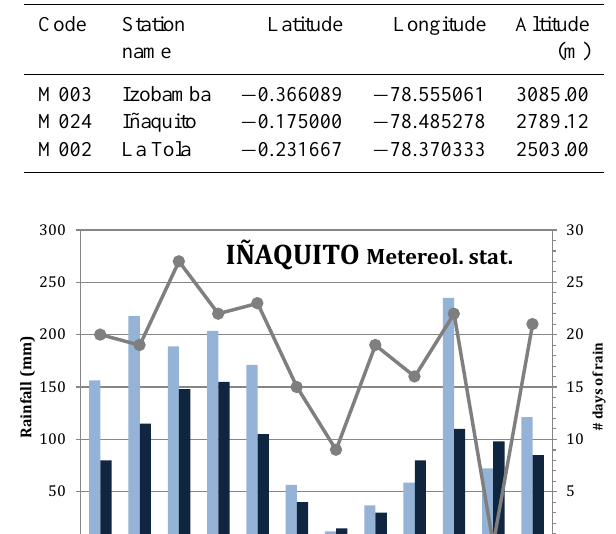
Table 1. INAMHI’s Meteorological Automatic Stations closest to El Trébol area.